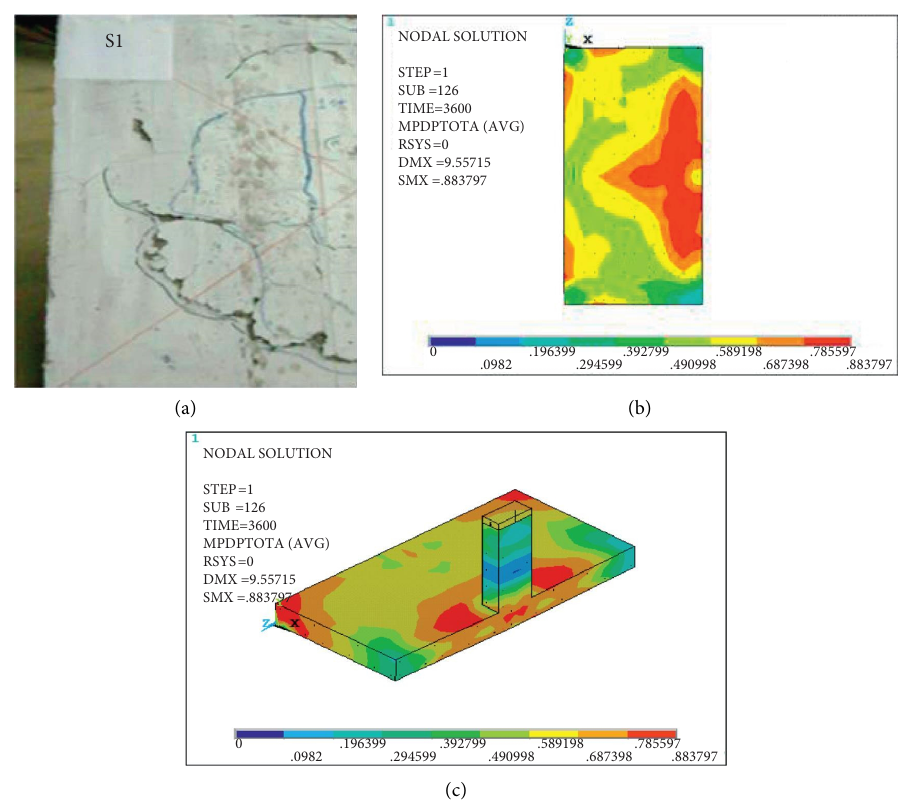
Figure 25: Comparison of concrete damage of specimen S1 due to 3600sec fre exposure and maximum load. (a) Experimental half-scale [11]. (b) FEA half-scale plan view. (c) FEA half-scale 3D view.